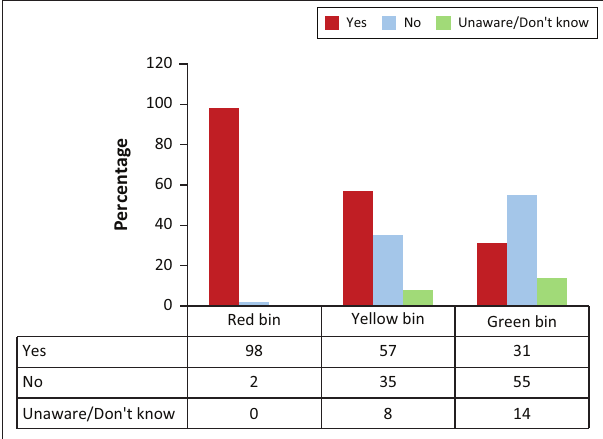
FIGURE 1: Frequency of disinfecting paediatric toys and touch surfaces ( n = 49).